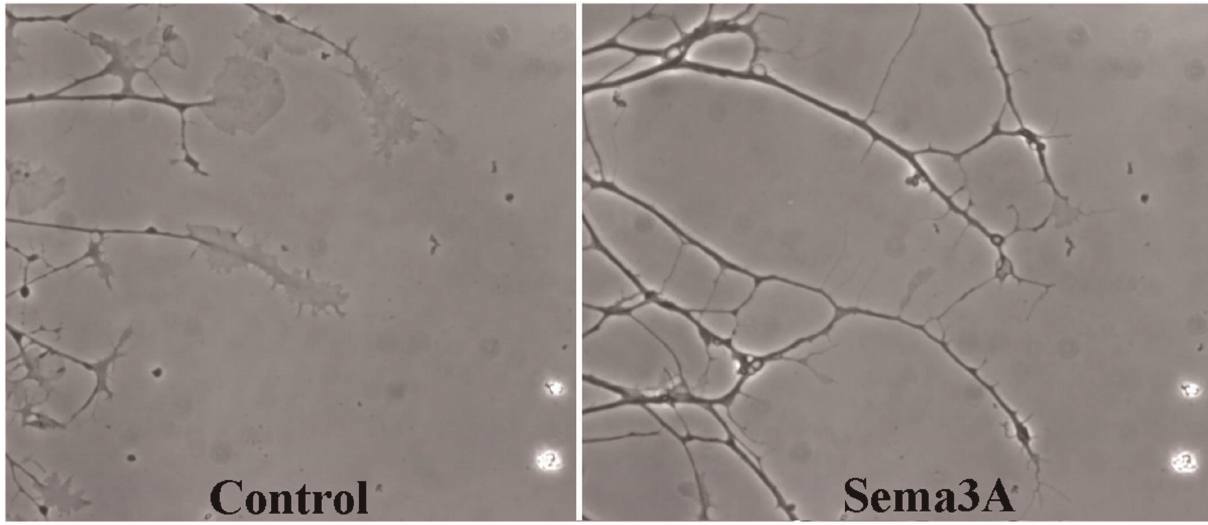
Figure 1. Growth cone morphology in control conditions and after application of Sema3A. Same region of time-laps microscopy represents typical morphology change of growth cones grown for 23 hours in control conditions and after 60 minutes incubation with 100 ng/mL of